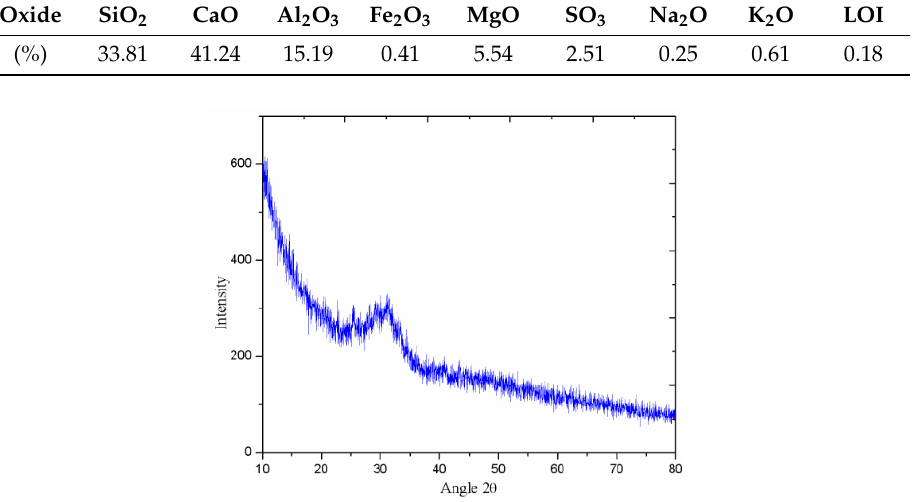
Table 1. Chemical composition of used blast furnace slag.